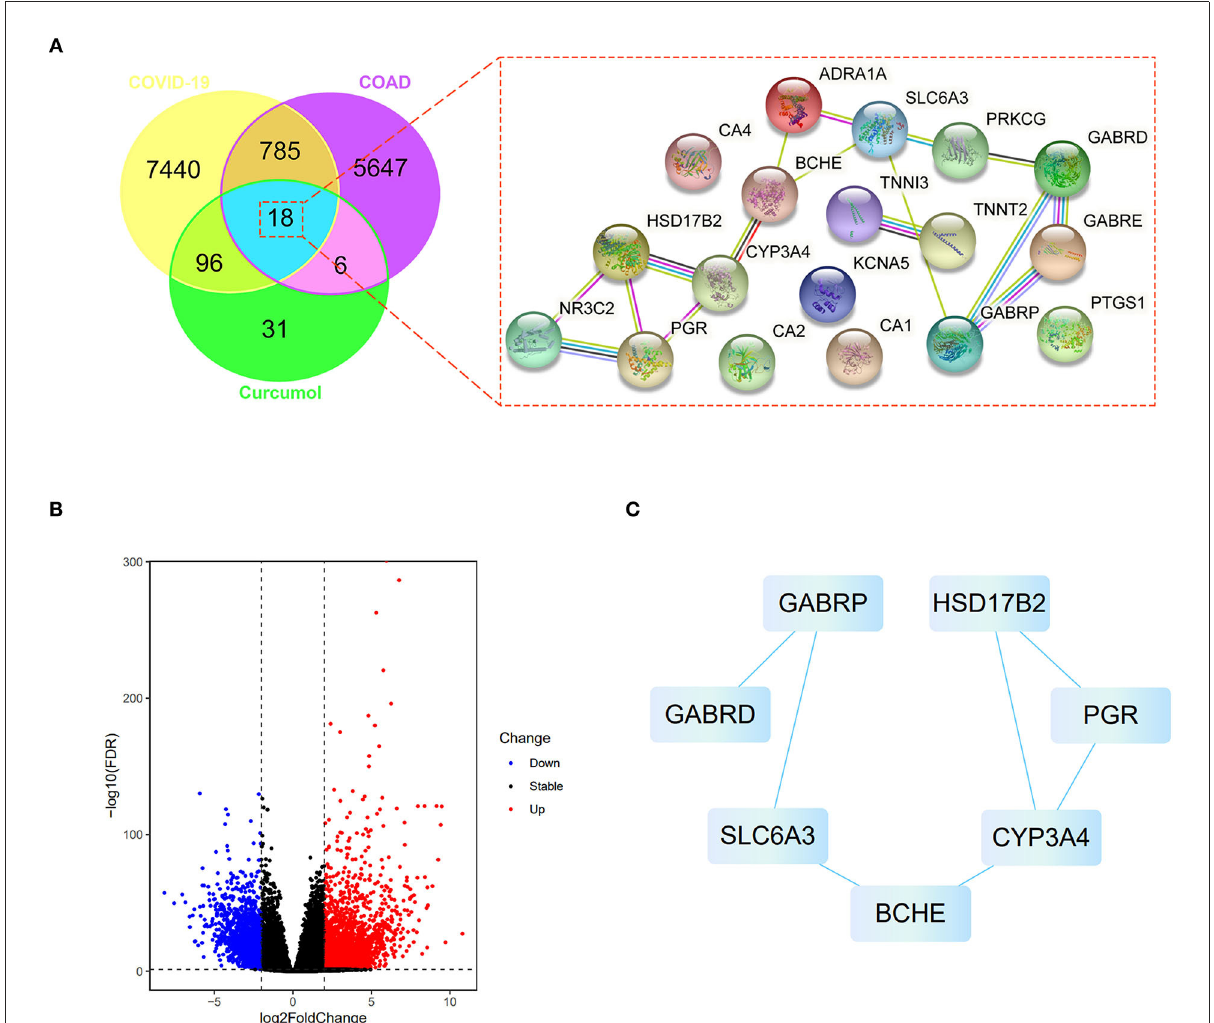
FIGURE1 Network pharmacology identified the targets of curcumol against COVID-19 and colon adenocarcinoma. (A) Right panel: venn diagram shows the number of common targets of curcumol, COVID-19, and colon adenocarcinoma. Left panel: protein–protein interaction of curcumol’s target against COVID-19 and colon adenocarcinoma. (B) Volcano plot shows the differentially expressed genes in colon adenocarcinoma targeted by curcumol. The blue dots represent the downregulated genes; the red dots represent the upregulated genes. (C) Cytoscape analysis highlights the protein–protein interaction of curcumol’s core targets against COVID-19 and colon adenocarcinoma.